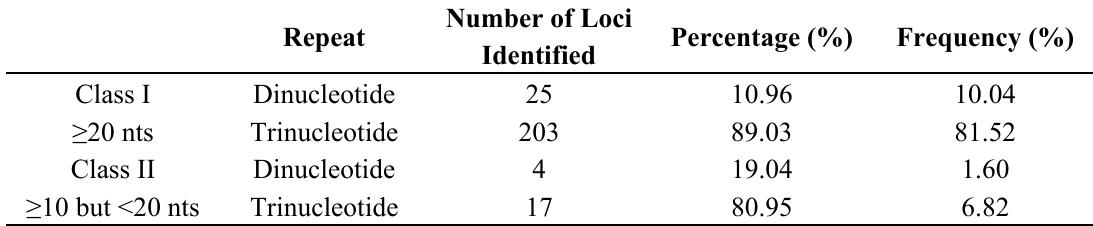
Table 3. Frequency distribution of two repeat types (di- and tri- motif units) microsatellites identified in contigs from the PGM™ sequencing of genomic DNA from P.